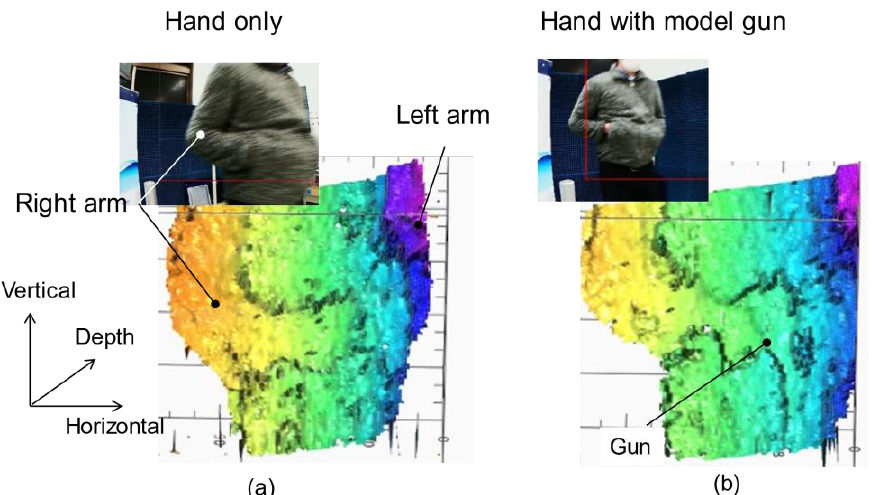
Figure 16. ( a ) 3D image measured with only the hand in the pocket. ( b ) 3D image measured by holding a model gun in the pocket.